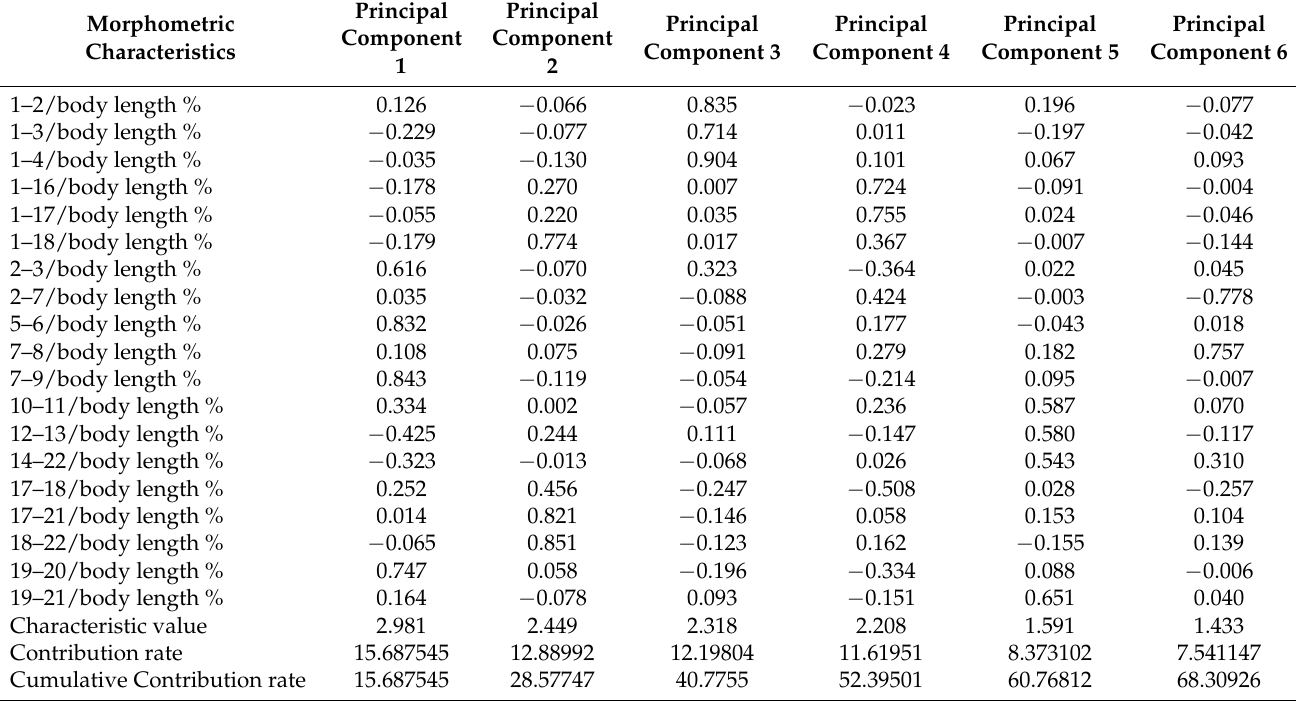
Table A2. Principal component analysis of grass carp in the lotic environment.